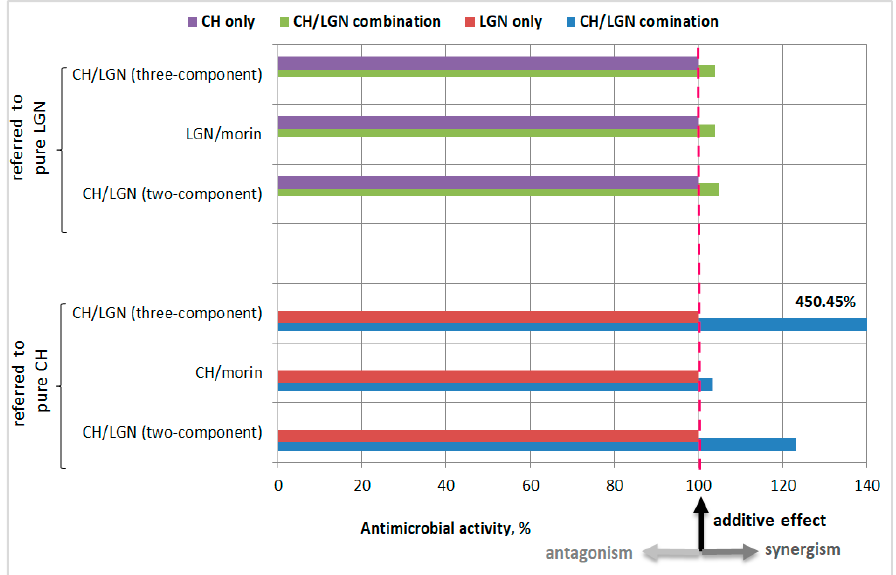
Figure 4. Effects of CH and LGN combinations on S. aureus inhibition as a percentage of the effect of both biopolymers applied alone.